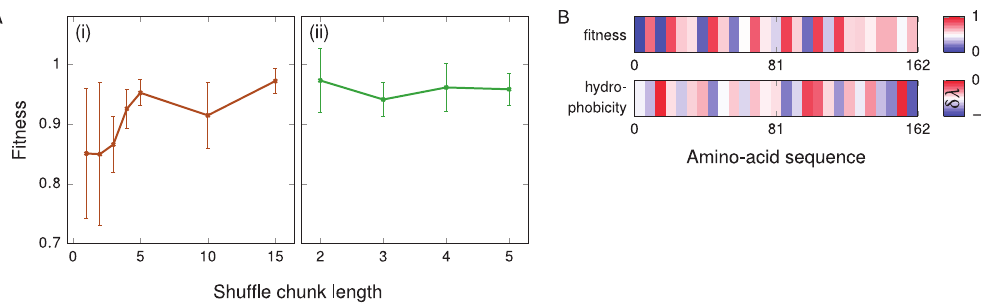
Fig 3. Determining the characteristic length scale. (A) (i) The fitness of the system as a function of the chunk length following the shuffling of approximately 100 amino acids. Error bars show the standard deviation across several shuffling runs. There is a significant difference in the fitness and the error bars for small chunks of 1 and 2 amino acids, whereas the error bars for the larger chunk sizes are considerably smaller. (ii) Analogous results for shuffling runs with a hydrophobicity bias, where exchanges were allowed only amongst the top 30% of chunks by hydrophobicity. Representative fitness functions as a function of the number of amino-acid pairs shuffled are shown in S5 Fig. (B) The value of the fitness function (relative to the WT fitness) when chunks of 6 amino acids of FUS-WT are separately replaced with glycine, and the average hydrophobicity of these same 6-residue chunks of FUS-WT relative to the hydrophobicity parameter of glycine, δ λ = h λ i chunk − λ (G), where λ (G) = 0.649. Where glycine represents a gain in hydrophobicity, the fitness change is largely positive, and vice